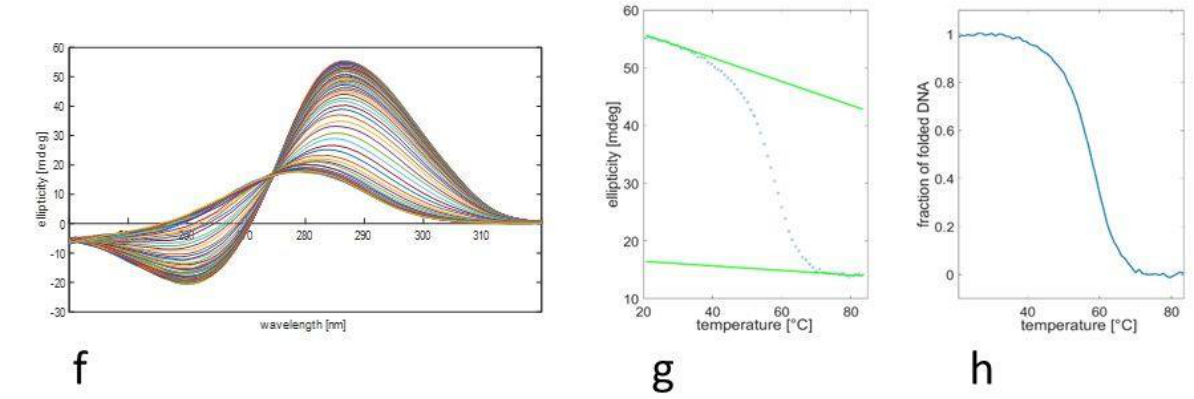
Figure 4. pH 5: CD spectra of 22nt ( a ), nmyc01 ( b ), and nmyc01m ( c ) in the absence (blue) and presence (red) of escholidine in acetic buffer (c oligo = 2 µ M, t = 20 ◦ C). pH 7: CD spectra of GG1 ( d ), and DL40 ( e ), in the absence (blue) and presence (red) of escholidine at phosphate buffer (coligo = 2 µ M, t = 20 ◦ C). Temperature dependence: CD spectra recorded along with the melting experiment of nmyc01 ( f ), ellipticity trace measured at 287 nm ( g ), and the fraction of folded DNA calculated assuming an intramolecular two-step process ( h ).